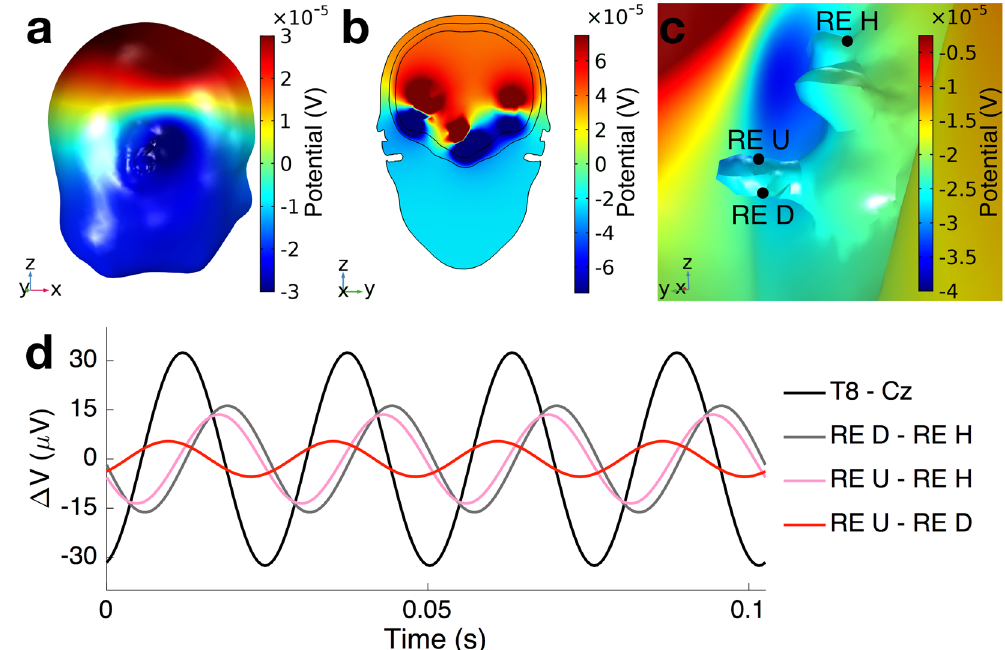
Figure 3. Simulated electric potentials in the head at time 0 s, generated by dipoles which oscillated at 39 Hz, with positive potentials shown in red and negative potentials in blue. ( a ) Potentials on the whole scalp; ( b ) Potentials in the coronal plane; ( c ) Potentials in the right ear region seen from inside the head (note that ( a – c ) have different scales); ( d ) Waveforms of potential differences between electrode pairs on the scalp and inside the ear canal. The T8 and Cz positions are standard on-scalp EEG electrodes and further abbreviations are: RE D: Right ear canal, downward direction; RE U: Right ear canal, upward direction; RE H: Right ear, root of the helix. The positions of the ear electrodes are marked with black circles in panel ( c